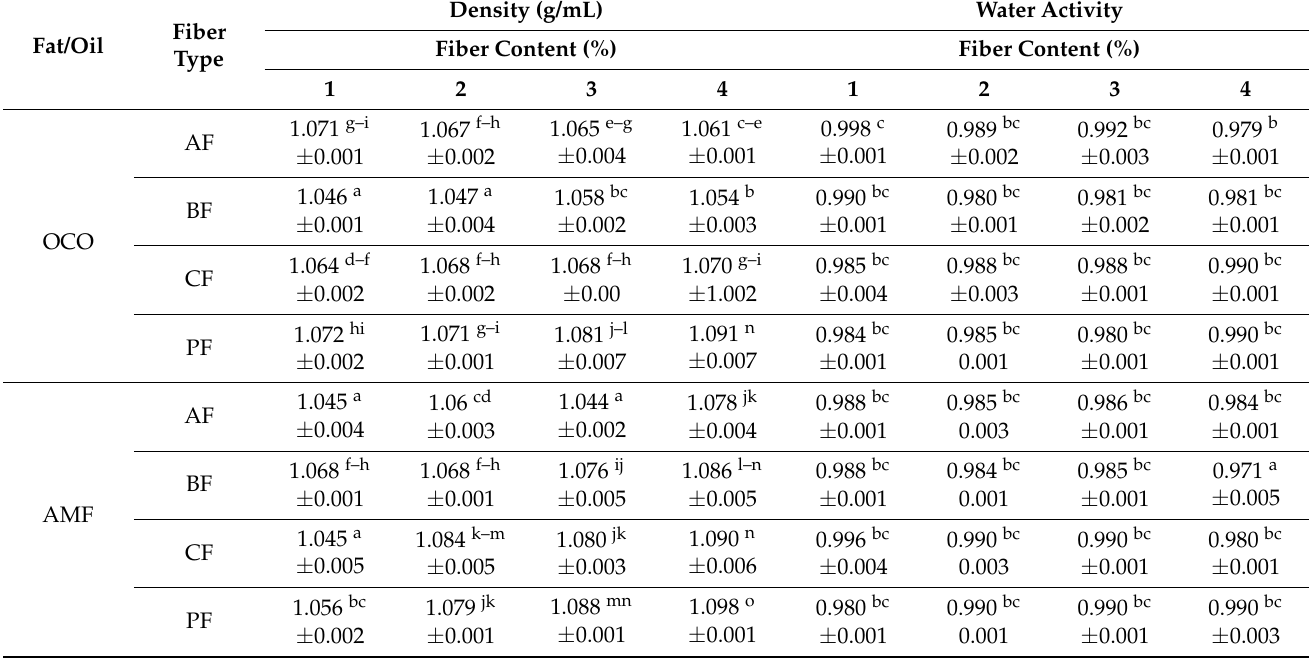
Table 5. Effect of different fibers concentration on density and water activity of acid casein PCS (processed cheese sauces) with WPC80 (whey protein concentrate) and OCO (organic coconut oil) or AMF (anhydrous milk fat).